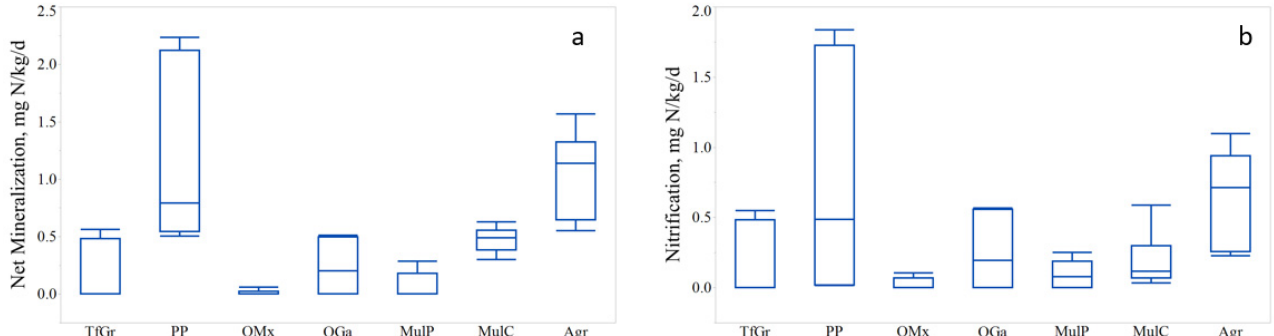
Figure 1. Net N mineralization ( a ) and nitrification ( b ) rates in landscape patches. Values based on whole-core basis. Agr; remnant agricultural field, TfGr; turfgrass, PP; perennial peanut, OMx; patches with a mixture of ornamental grasses, OGa; patch with gamma grass, MulP; patch with pine needle mulch, MulC; patch with pine bark nuggets.